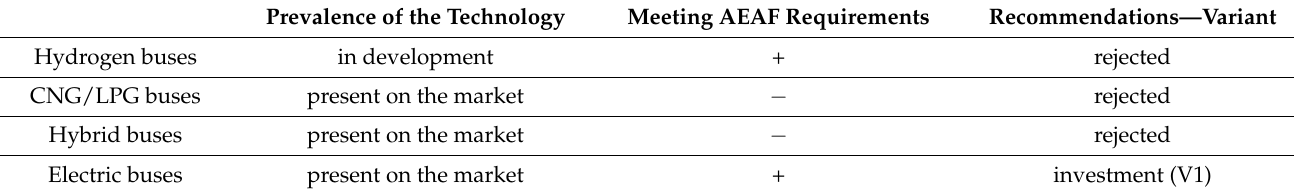
Table 2. Selection of the investment